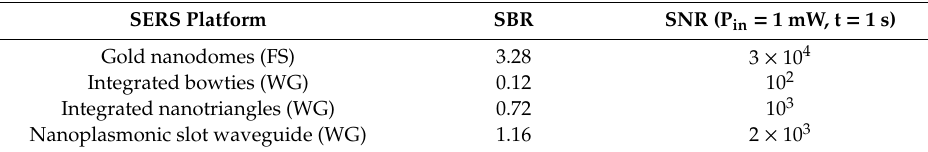
Table 1. The signal-to-background ratio (SBR) and signal-to-noise ratio (SNR) values at P in = 1 mW and t = 1 s for di ff erent SERS platforms evaluated based on the 1339 cm − 1 mode of a NTP monolayer. If we use another input power or integration time, the absolute value of the SNR will change, but the relative SNR of di ff erent SERS platforms will remain the same. FS indicates free-space and WG is the waveguide-based excitation and collection of the SERS signal. For the sake of this table, only the shot noise contribution from the background is taken into account (as it will be more relevant when looking for weaker peaks than the 1339 cm − 1